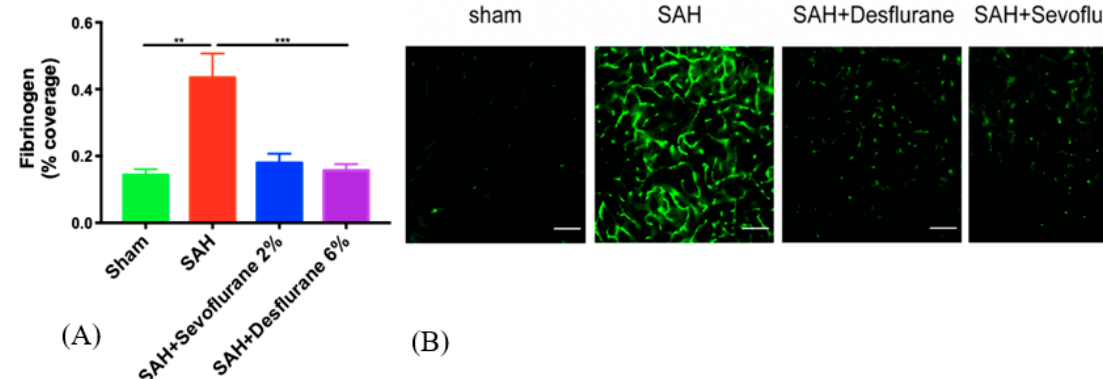
Figure 3. Sevoflurane and desflurane conditioning attenuates SAH-induced microvessel thrombosis: Mice were exposed to 2% sevoflurane, 6% desflurane, or room air for one hour, one hour after the SAH or sham surgery. ( A ) Fibrinogen percent coverage (%) was examined on day 3. Data are presented as mean ± SEM. A one-way ANOVA and post-hoc Student–Newman–Keuls test were used to compare groups: Sham vs. SAH + room air ** ( p < 0.01), SAH + room air vs. SAH + Sevoflurane *** ( p < 0.001), SAH + room air vs. SAH + Desflurane *** ( p < 0.001). ( B ) Representative images—fibrinogen immunofluorescence assay . Scale corresponds to 100 uM.